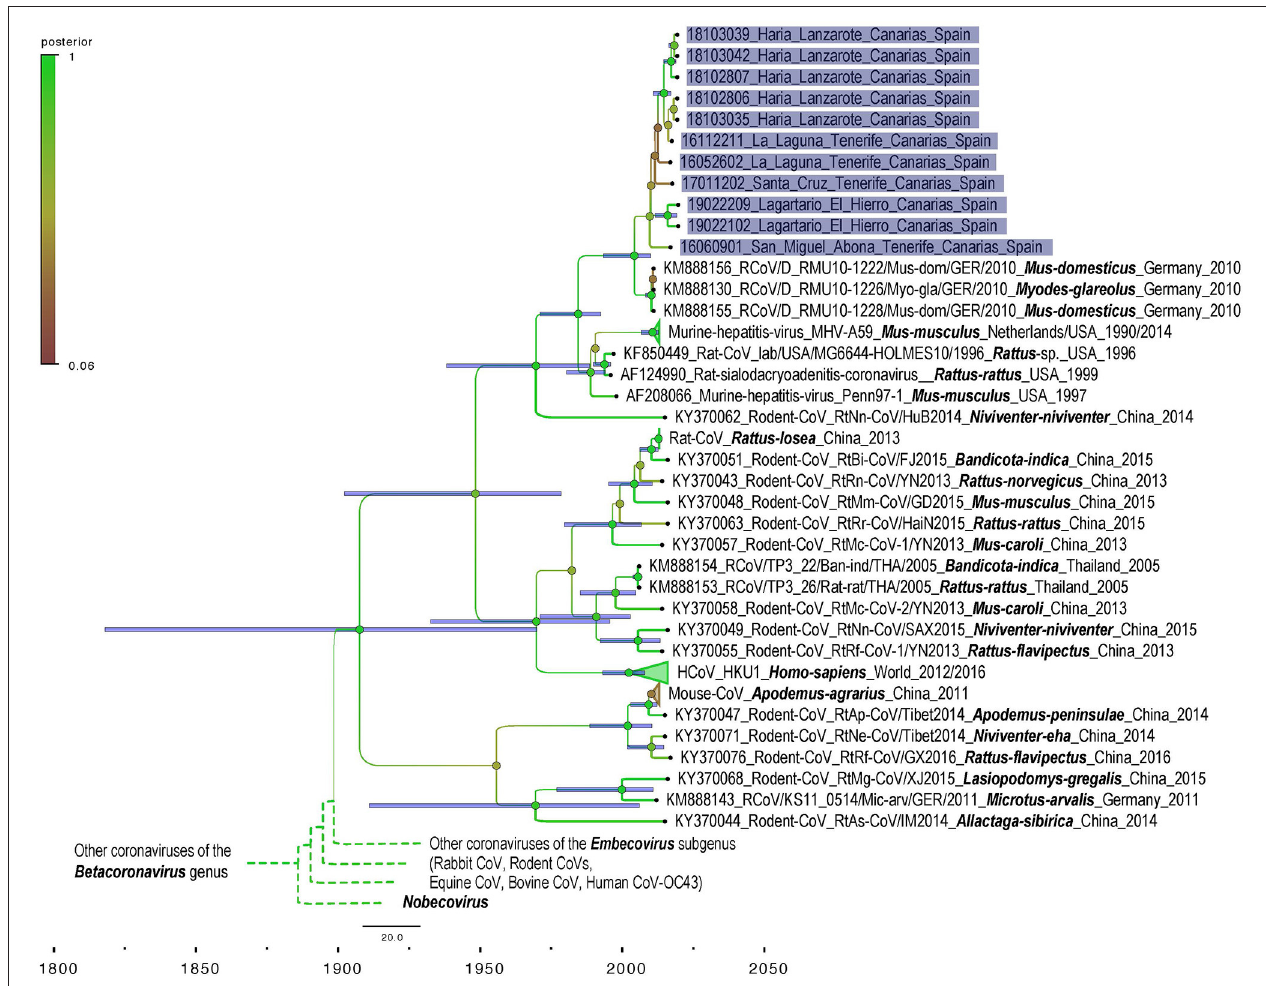
Figure 2 . Blue bars indicate 95% HPD interval around the mean value for each